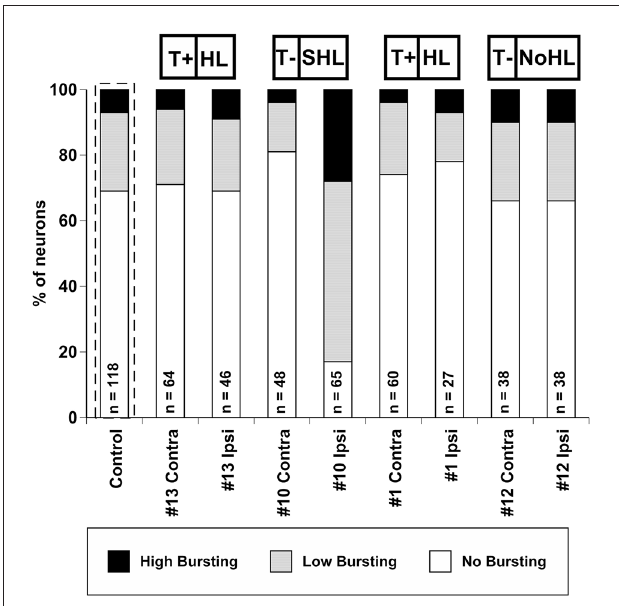
FIGURE 6 | Percent distribution of auditory neurons having different levels of bursting activity (high bursting, low bursting, and no bursting) in conta- and ipsilateral ICs of four exposed mice . The average distribution from four control (unexposed) mice is outlined by a dashed line. The number of neurons collected is labeled for each exposed IC (or all ICs for control). Tinnitus and hearing loss abbreviations are taken from Figures 1 , 2 respectively.